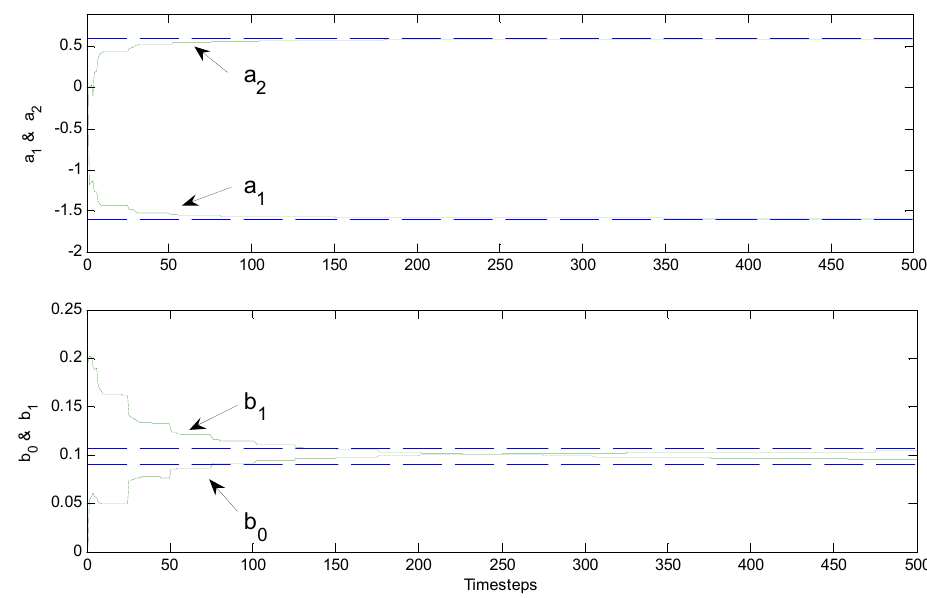
Figure 4. Parameter identification, indirect self-tuner (without zero cancellation) of minimum phase system.